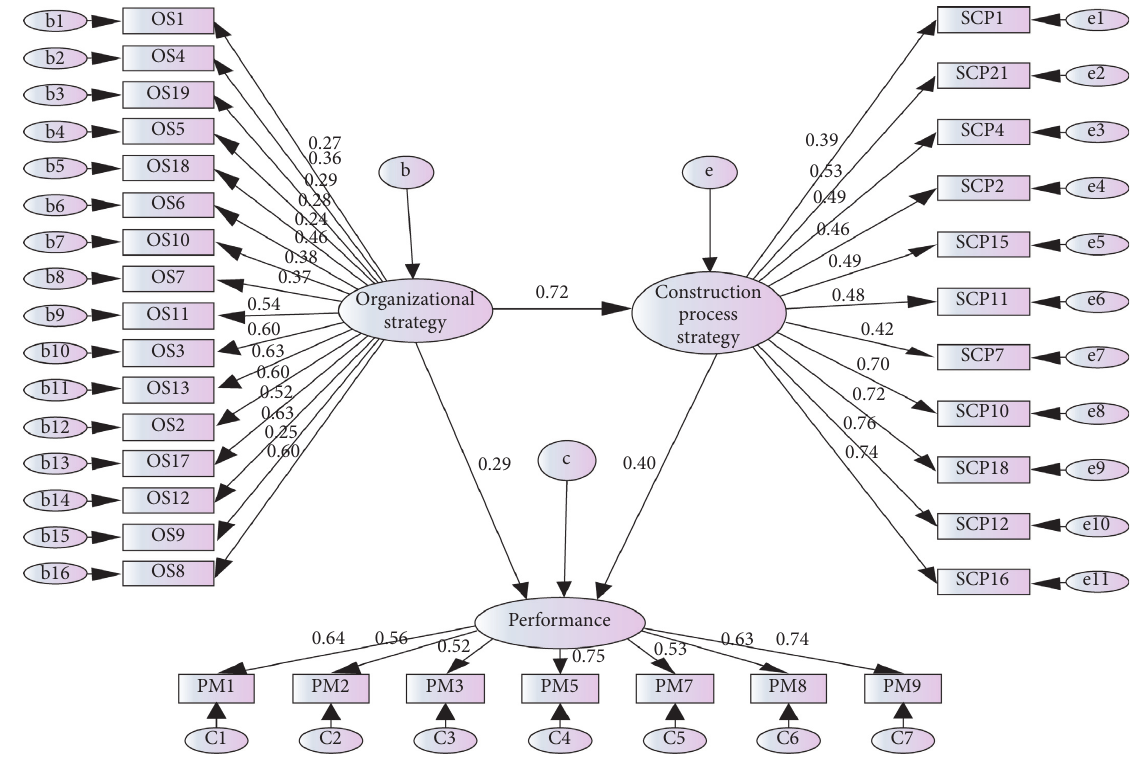
Figure 4: A structural modelling diagram; source: researchers. Table 12: Model fit indices